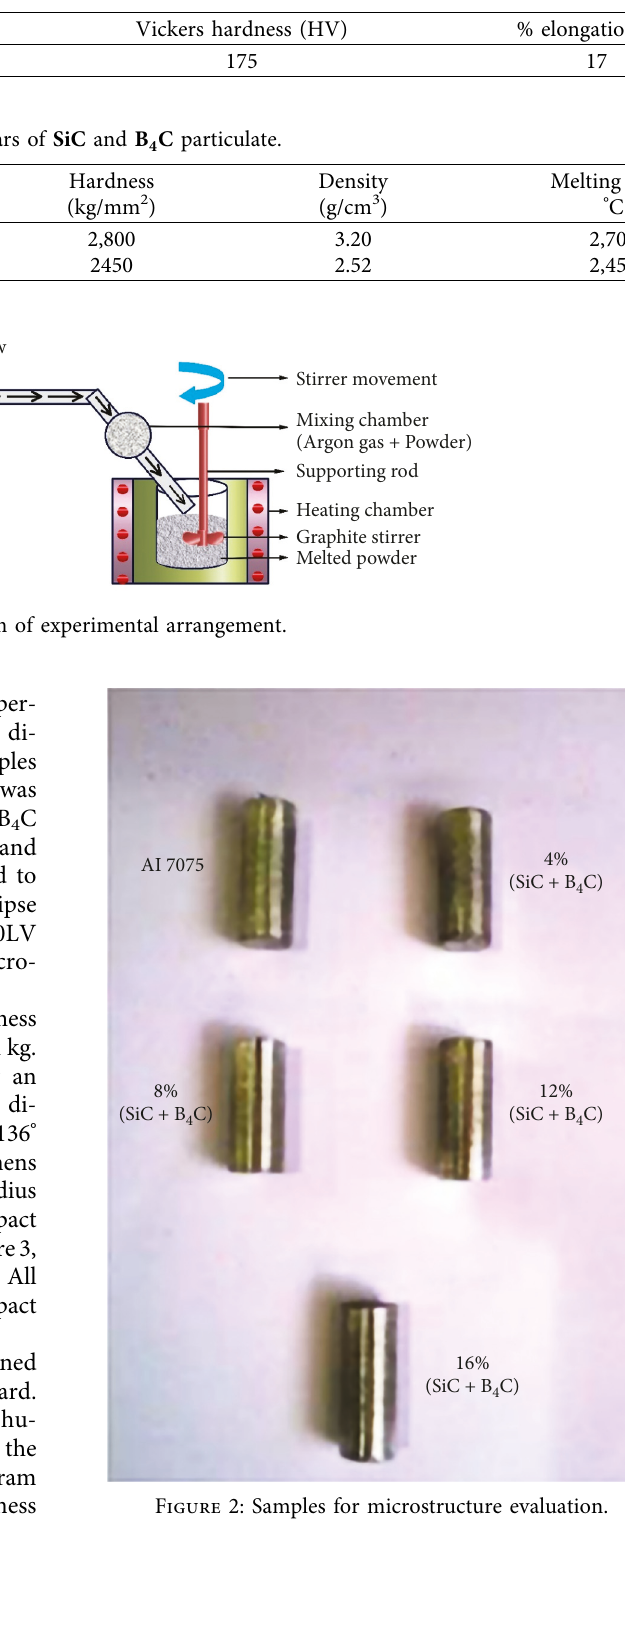
Table 2: Mechanical properties of AA7075.